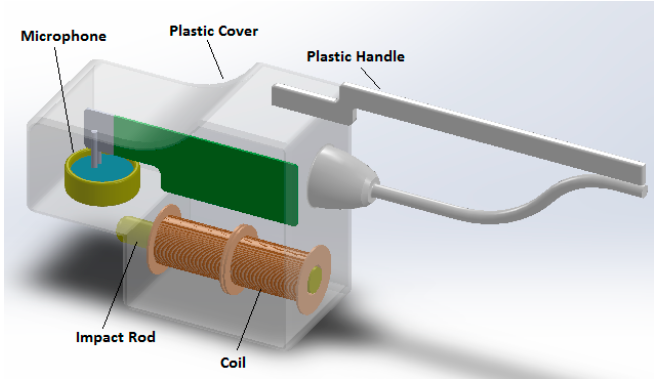
Figure 3. The Implomates device.